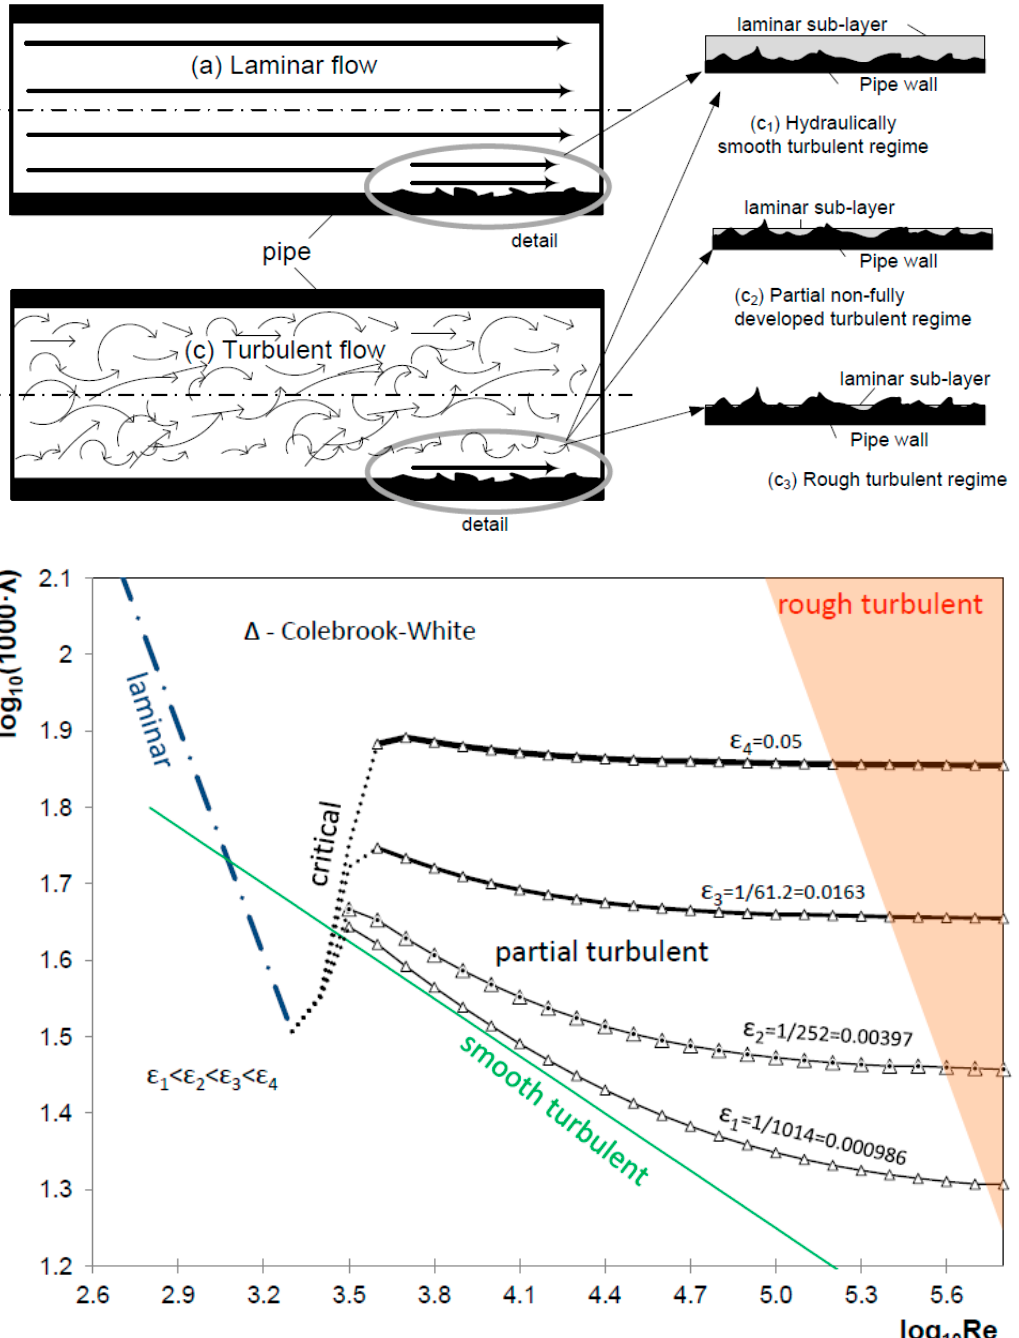
Figure 1. Hydraulic regimes for pipe flow: the laminar regime ( a ) , the sharp transition from the laminar regime to the smooth turbulent regime (critical) ( b ) , the smooth turbulent regime ( c 1 ) , the non-fully developed partially turbulent regime ( c 2 ) , and the fully developed rough turbulent regime ( c 3 ) . ( top ) contains physical interpretations, while ( bottom ) contains related diagrams.